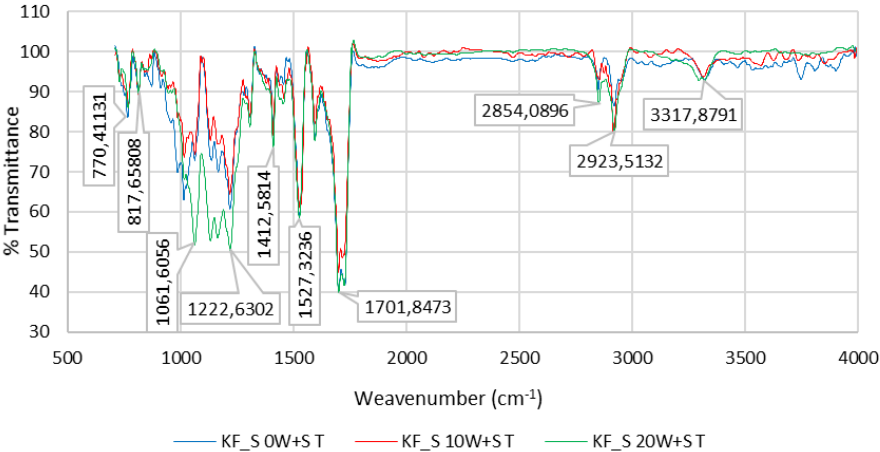
Figure 12. FTIR spectrum of the PU coating of sample KF_S (PU 50%/PES 50%) for 0 W+S, after 10 W+S and after 20